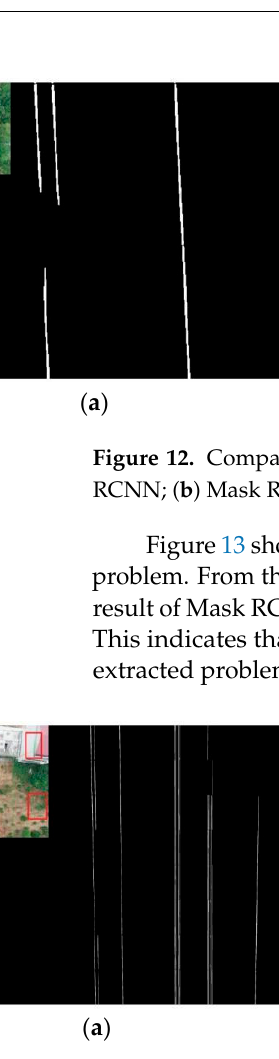
Figure 13. Comparison of two methods to solve the error detection problem. ( a ) Mask RCNN; ( b ) Mask RCNN + CDGFA.